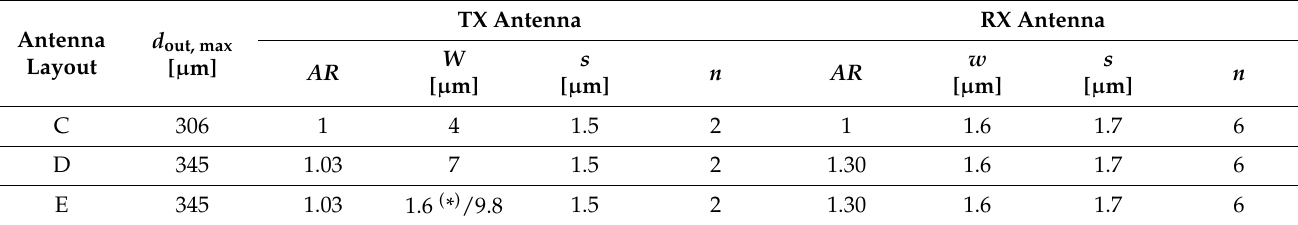
Table 2. Geometrical parameters of TX/RX antennas.